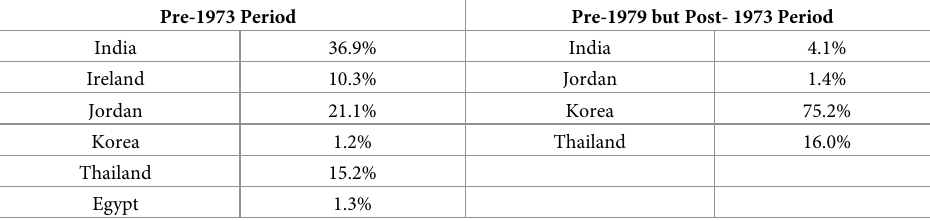
Table 2. Countries resembling China with significant